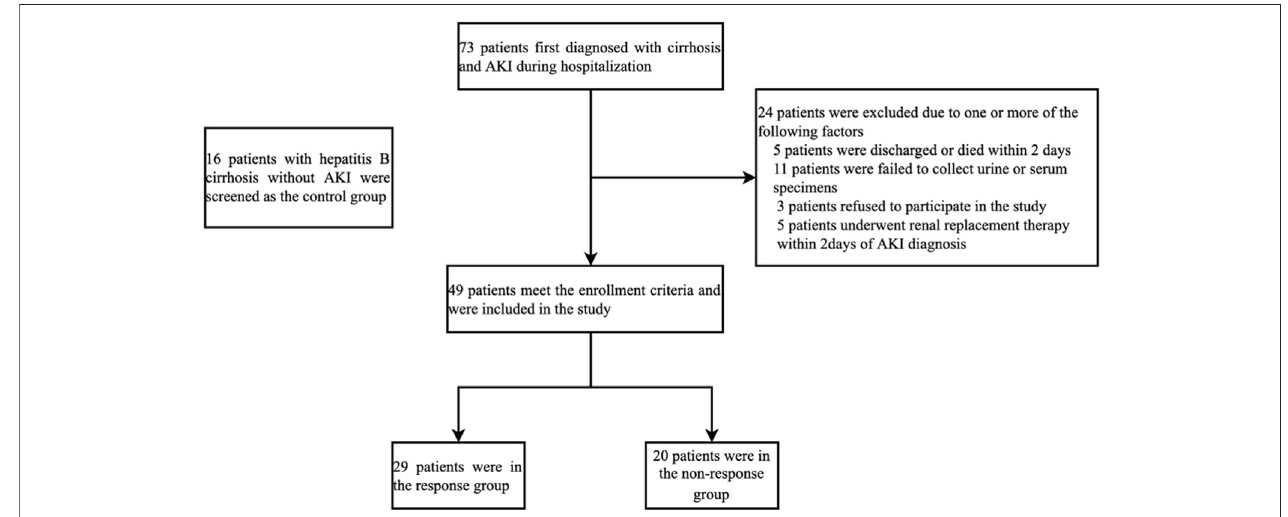
FIGURE 1 | Screening process for patients with hepatitis B cirrhosis and AKI. Abbreviations: Acute kidney injury.